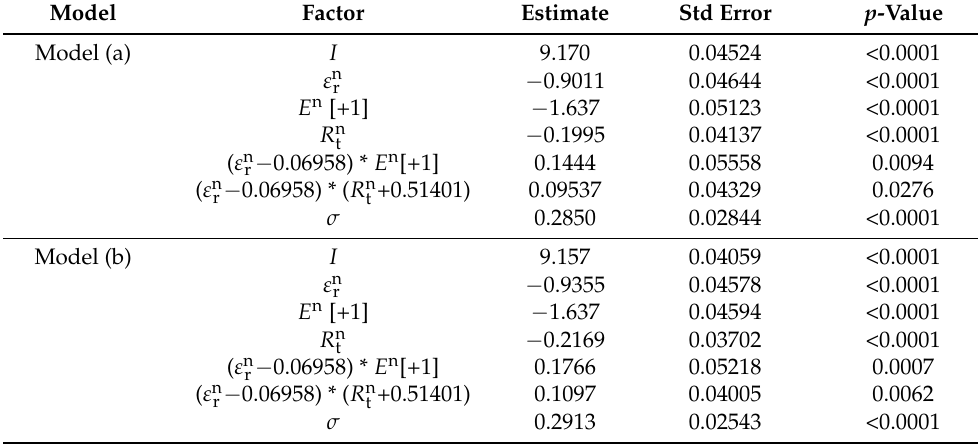
Table 6. Coefficients for the best models in Figure 4. Note that the normalized versions of the factors need to be used (Table 5); in the case of the categorical variable E n the coefficient is zero for E n = − 1 and the value in the table for E n = +1. The p -value in the last column is an indication of the statistical significance of an effect; a threshold of 0.05 is often used as criterion for statistical significance with lower values indicating higher significance. σ is a parameter in the lognormal distribution (Equation